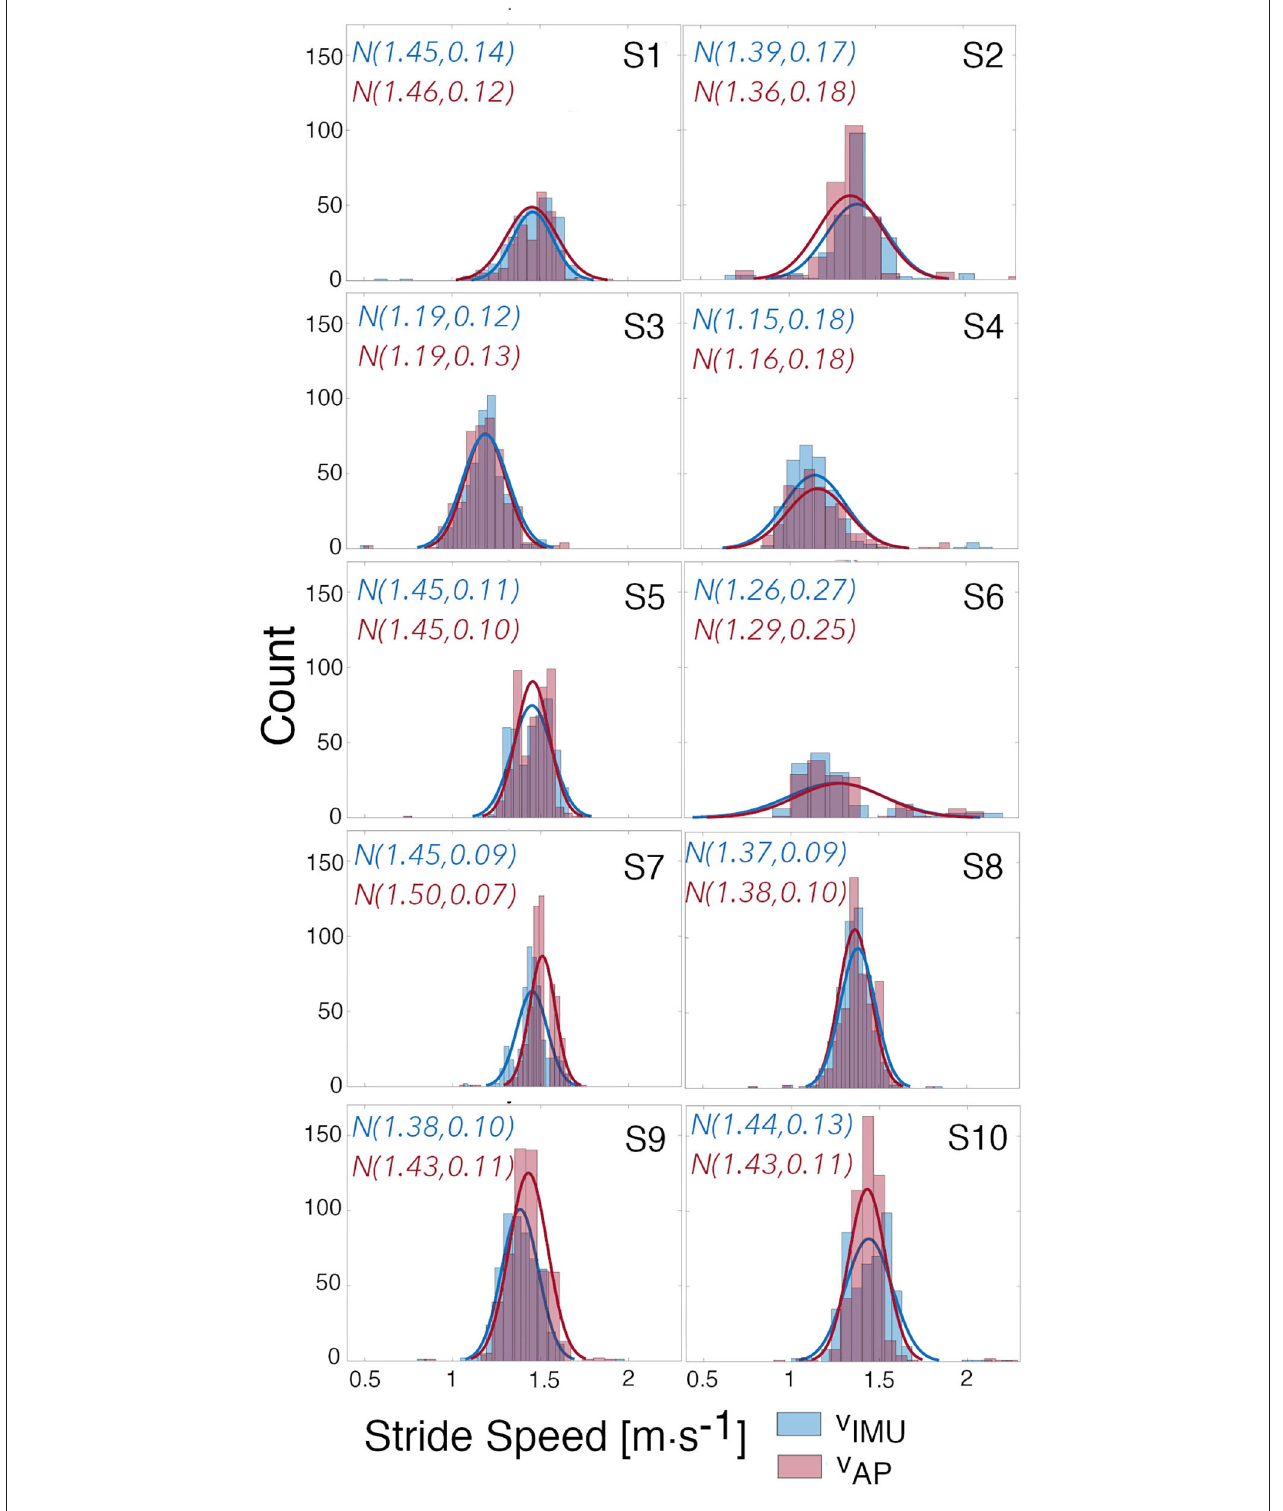
FIGURE 8 | Distributions of estimated and true speed. Distributions of the estimated speeds from the AP using the built models, and of the true speeds calculated from the IMU. Gaussian curves were fitted to each distribution and mean and standard deviation for each curve are given.